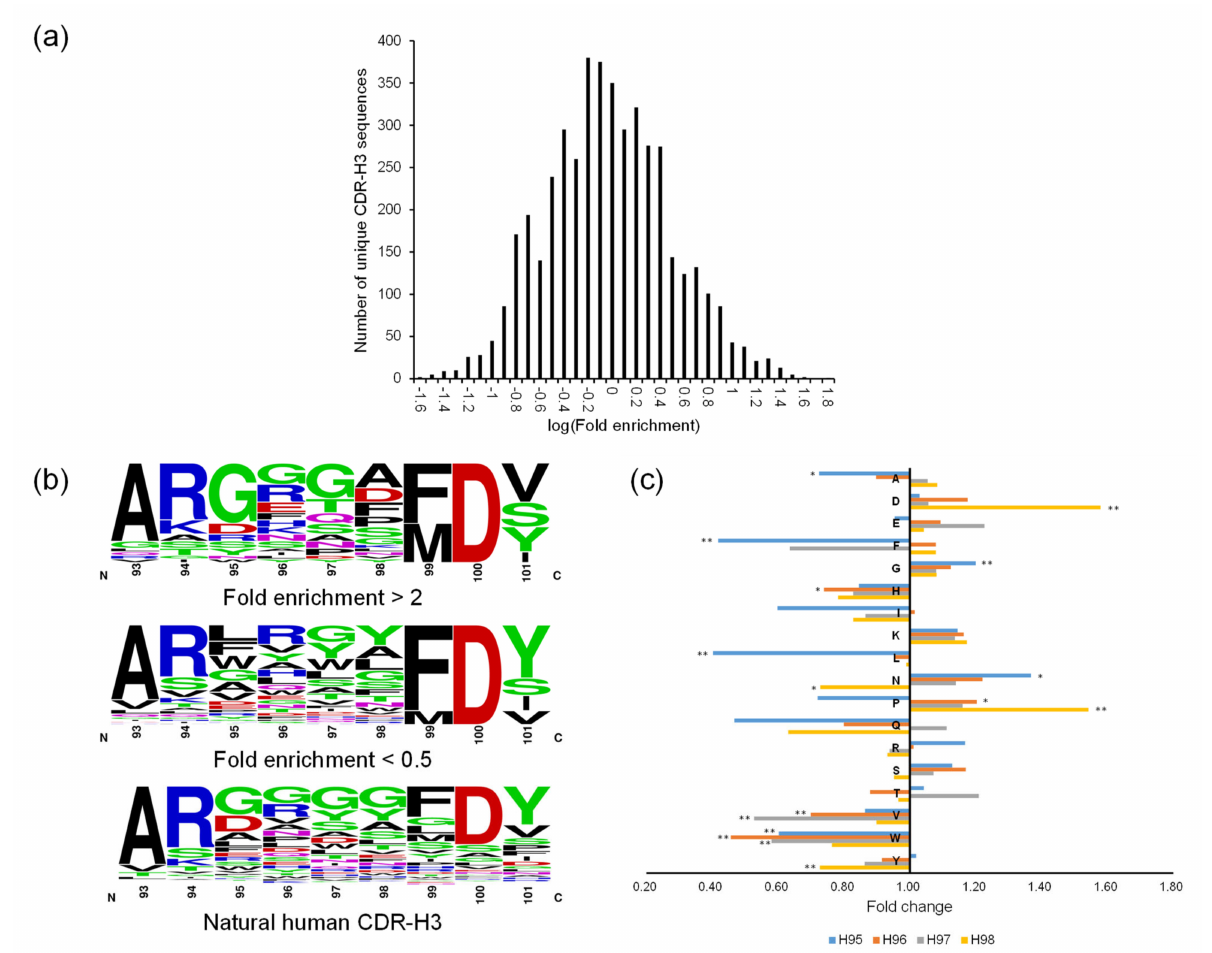
Figure 3. ( a ) CDR-H3 sequence read counts within the range of enrichment ratios (in logarithmic increment of 0.1) are presented as a histogram. A representative plot for CDR-H3 length 12 is shown here. ( b ) Logograms of CDR-H3 (length 9 aa) repertoires enriched ( top ) or depleted ( bottom ) more than twofold after the panning against protein A. Sequence logograms were created by WebLogo [21]. ( c ) Change in abundance of each of 18 aa (except Cys and Met, which had been excluded in the library CDR design) at each position from H95 to H98 of CDR-H3 (length 9 aa) before and after the panning against protein A. In ( b ) and ( c ), CDR positions are numbered according to Kabat numbering scheme. *: p < 0.05, **: p <